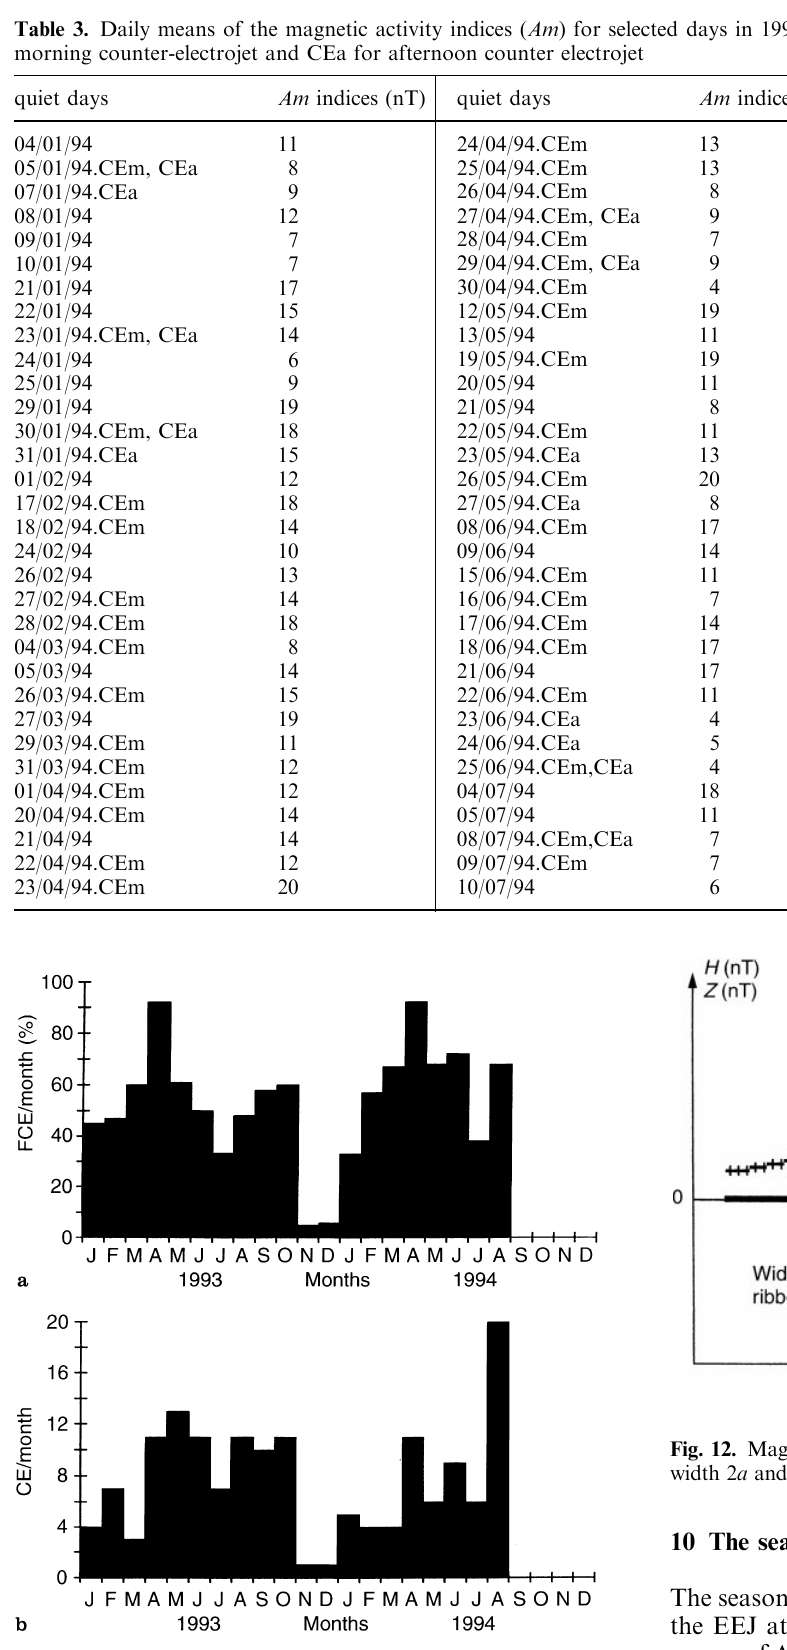
Fig. 11. a Seasonal variations of the numbers of CEJ occurrences observed each month. b Number of quiet days observed each month during the experiment